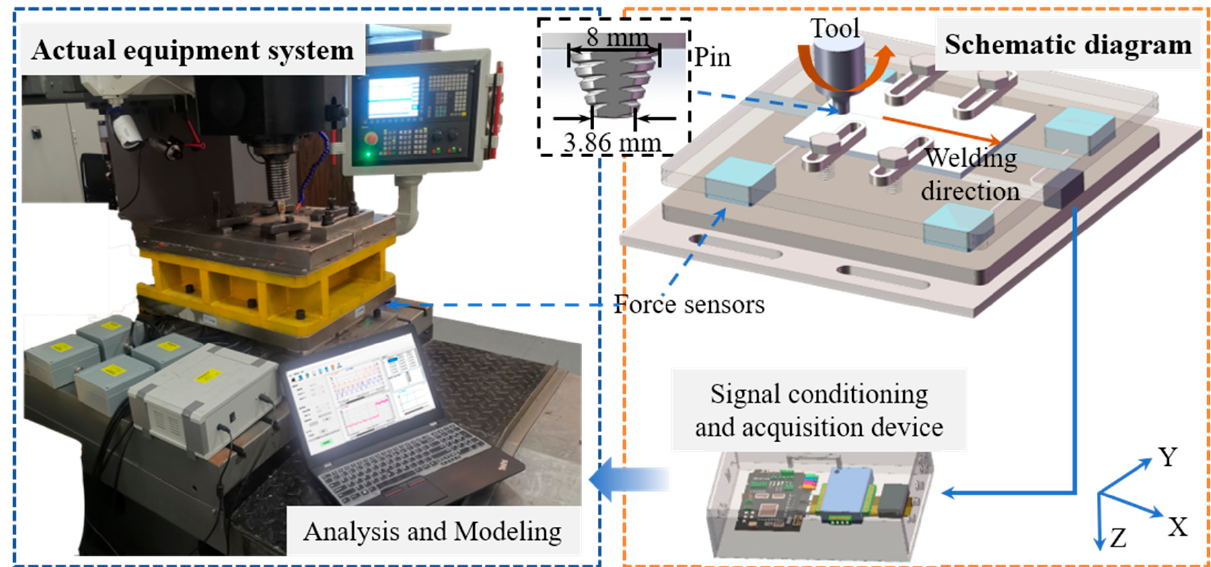
Figure 1. Photograph of the equipment system and schematic diagram of friction stir welding. During the experiments, the sampling frequency of three-dimensional force was set as 7.8 kHz. All welds were produced employing a tool-tilt angle of 2 ◦ and a plunge depth of 0.1 mm. In order to obtain defective and defect-free samples on the premise of sound surface-formation quality, the welding speed v ranged from 80 mm/min to 240 mm/min (with steps of 40 mm/min) and the rotational speed n ranged from 300 r/min to 600 r/min (with steps of 100 r/min). After welding, X-ray detection was employed to determine the presence of defects in the weld. Subsequently, several 5 mm × 20 mm metallographic samples were taken from the joint along the direction perpendicular to the welds. The samples were polished with sandpaper of 600 #, 800 #, 1000 #, 1200 #, and 1500 #, respectively, and then polished with a diamond polishing agent. To clearly observe the macroscopic morphology of the weld, Keller reagent was applied to corrode the welded joint for 30 s. The weld morphology was observed by optical microscopy to determine the internal quality of the